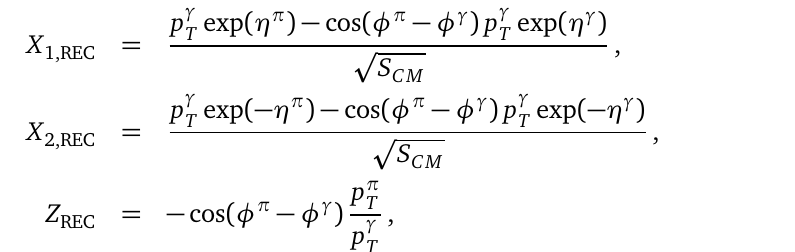
Figure 12: Correlation between the MC momentum fractions (i.e. X and the ones obtained at LO QCD accuracy using the LM approach. Each bin of the correlation plot is filled with the integrated